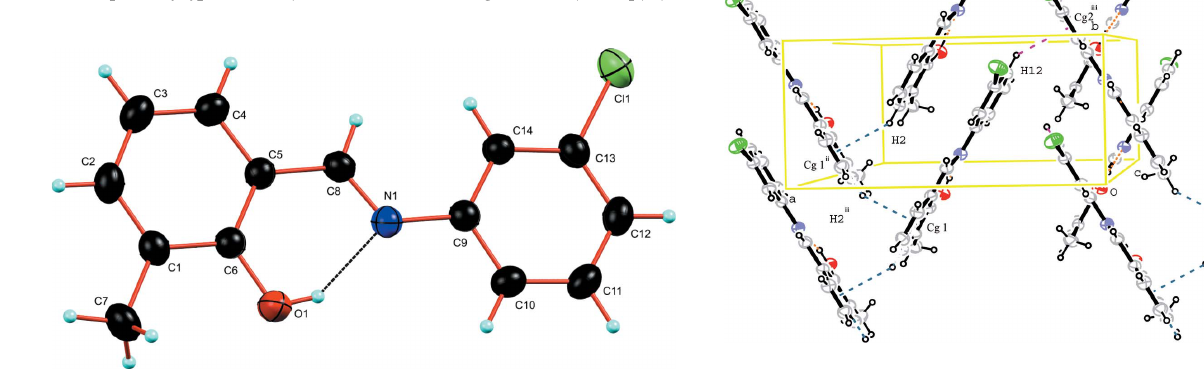
, y (cid:3) 1 , z ; (iii) (cid:3) x + 1 , y + 1 , z .. Cg 1 2 2 2 2